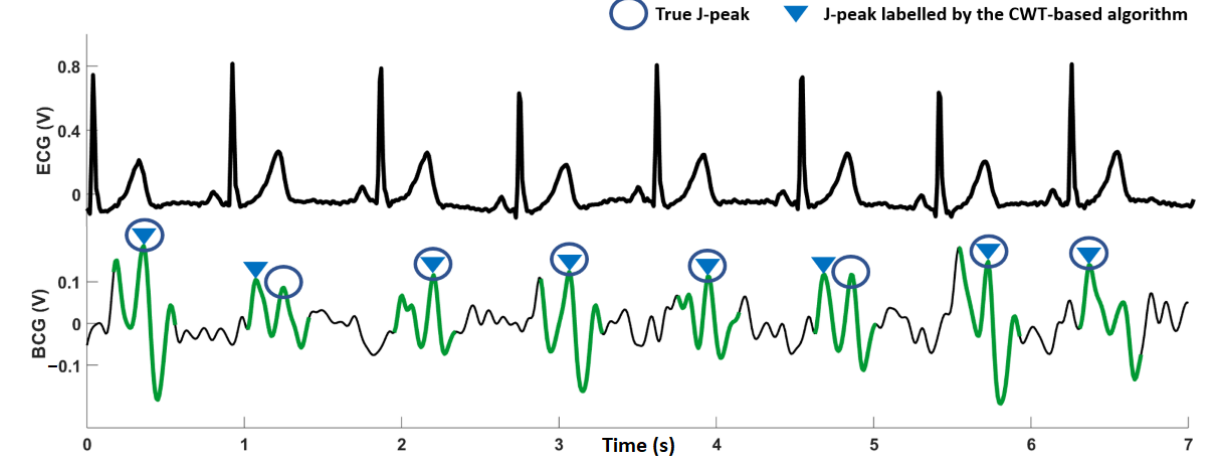
Figure 9. Seven seconds of electrocardiography and ballistocardiography recordings for participant 4. The signal is of poor quality visually, and the J-peaks are not easily distinguishable. This signal also had a very low signal-to-noise ratio. BCG: ballistocardiography; CWT: continuous wavelet transform; ECG: